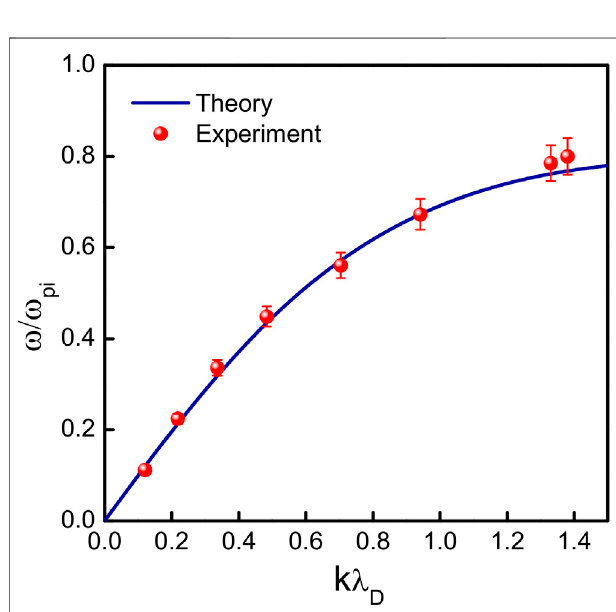
FIGURE 2 | Dispersion relation of ion acoustic wave. The solid line is the theoretical curve calculated from Eq. 1 .